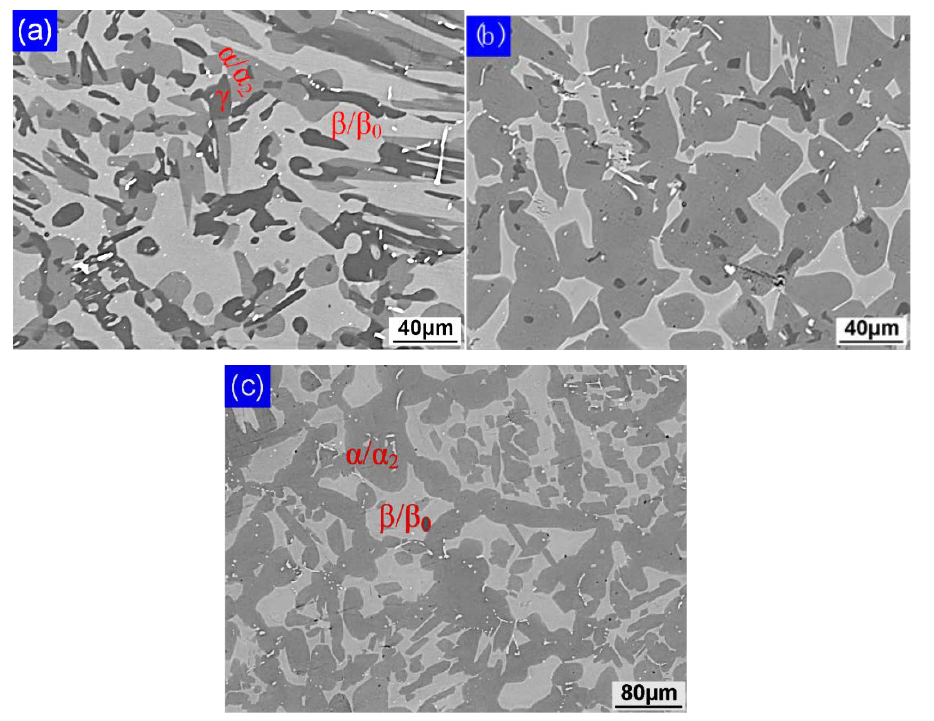
Figure 5. The microstructure of Ti-44Al-4Nb-4V-0.3Mo-Y alloy after heat treatment at different temperature following water quenching: ( a ) 1210 ◦ C; ( b ) 1240 ◦ C; ( c ) 1260 ◦ C.